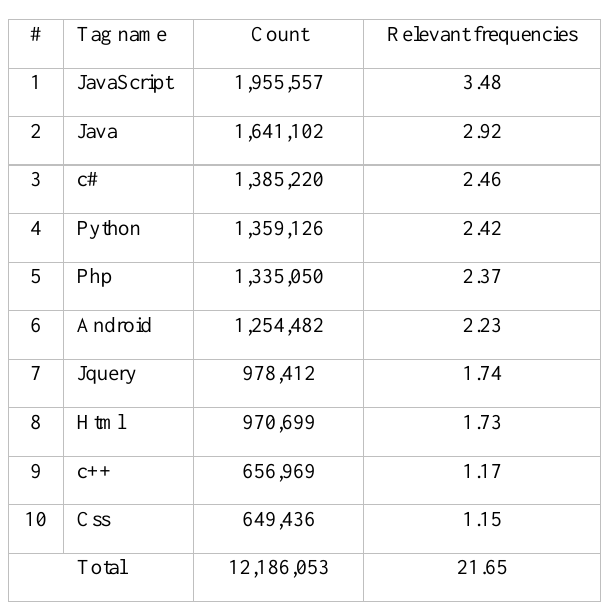
Table 2. Top 10 Tags time between (2008 and 2019).